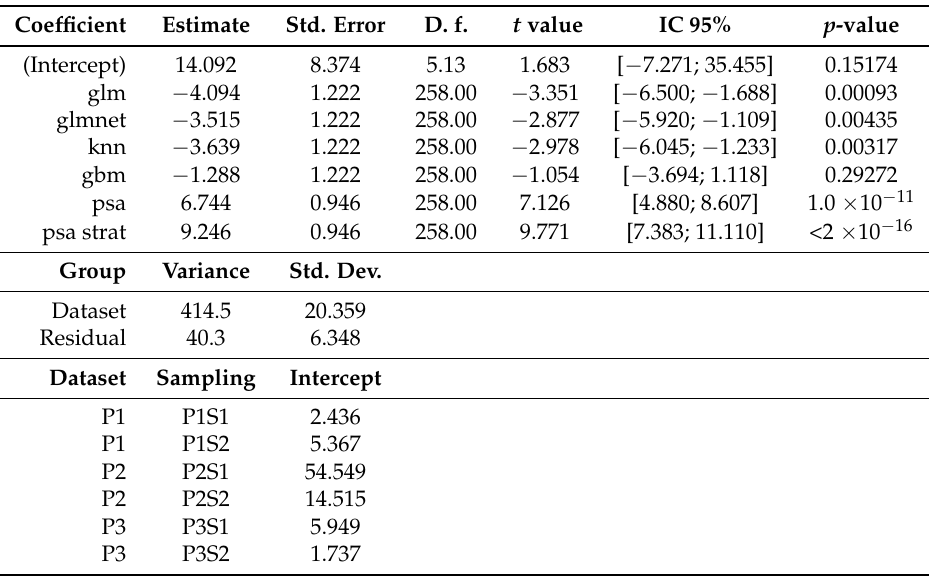
Table 4. Linear mixed-effects model on RMSE considering adjustment methods and algorithms as fixed effects and datasets as random effects. Reference levels: treebag algorithm and matching